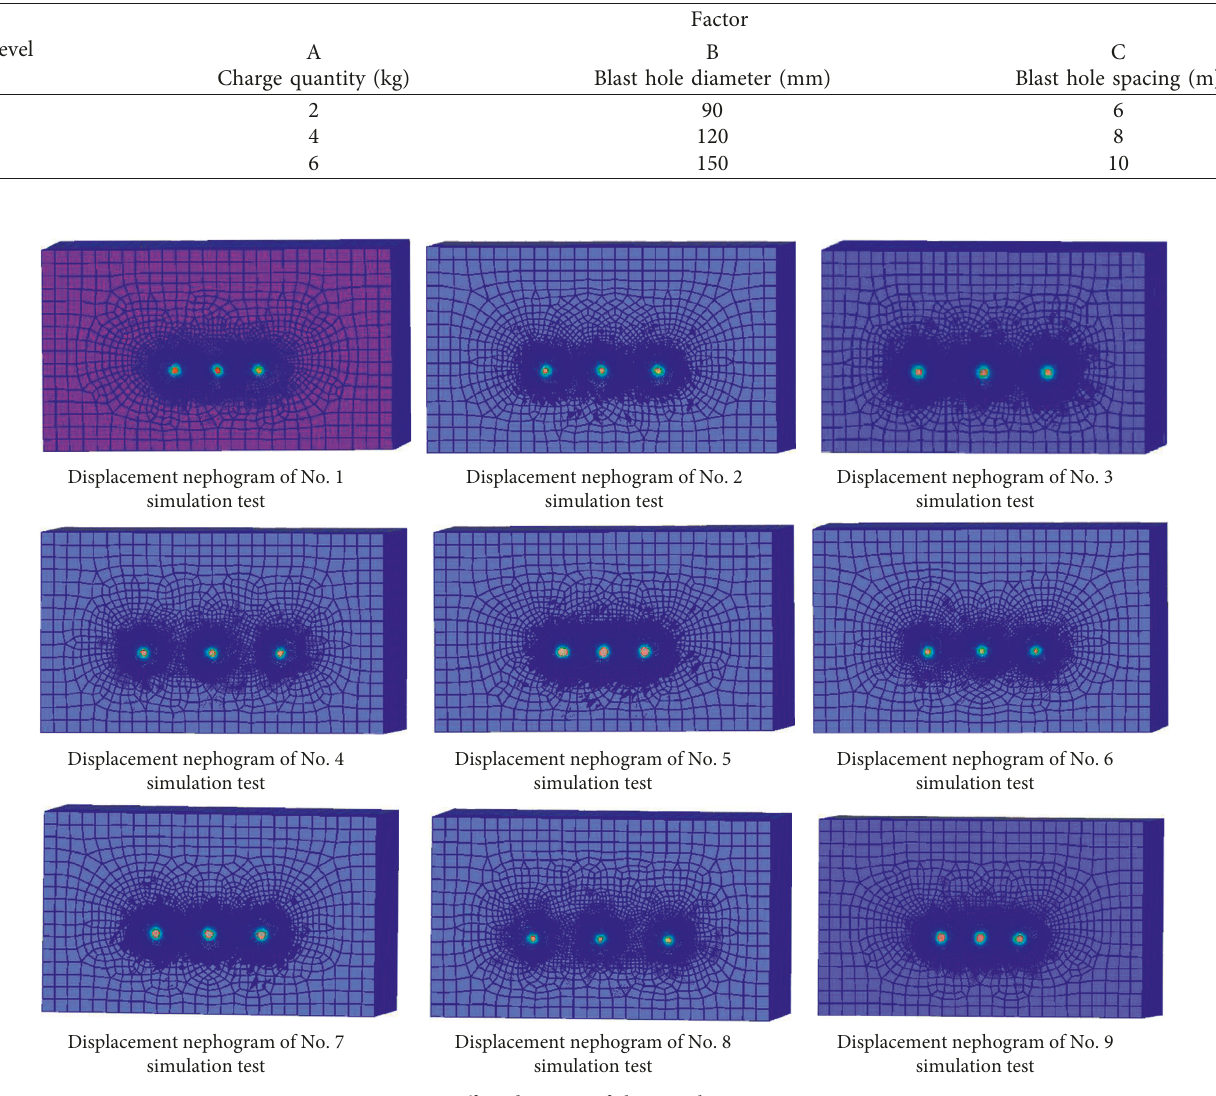
Figure 15: Effect diagram of the simulation